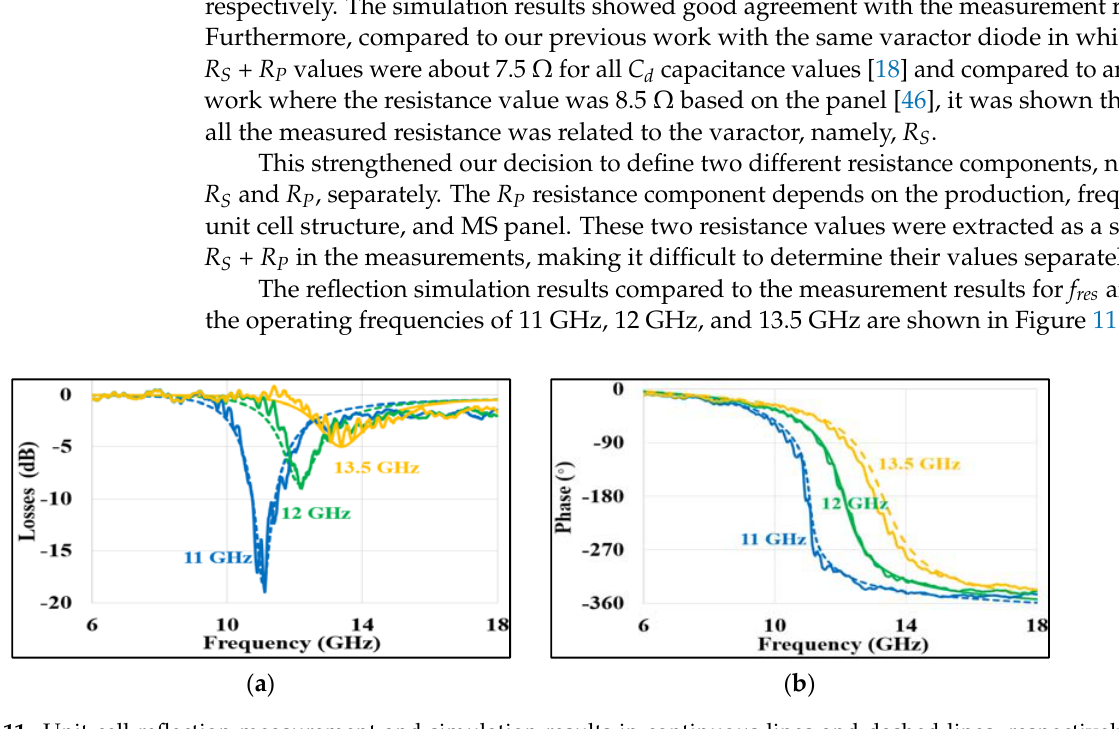
Figure 10. Unit cell reflection measurement and simulation results in continuous lines and dashed lines, respectively: ( a ) reflection magnitude and ( b ) reflection phase.